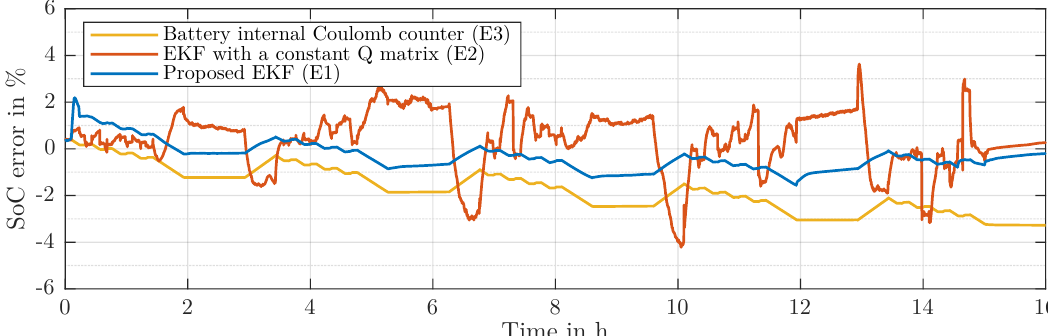
Figure 10. SoC estimation errors for the estimators E1, E2 and E3 referring to the SoC estimation of E4. The values are plotted in % and due to the unit of the SoC, they are not relative